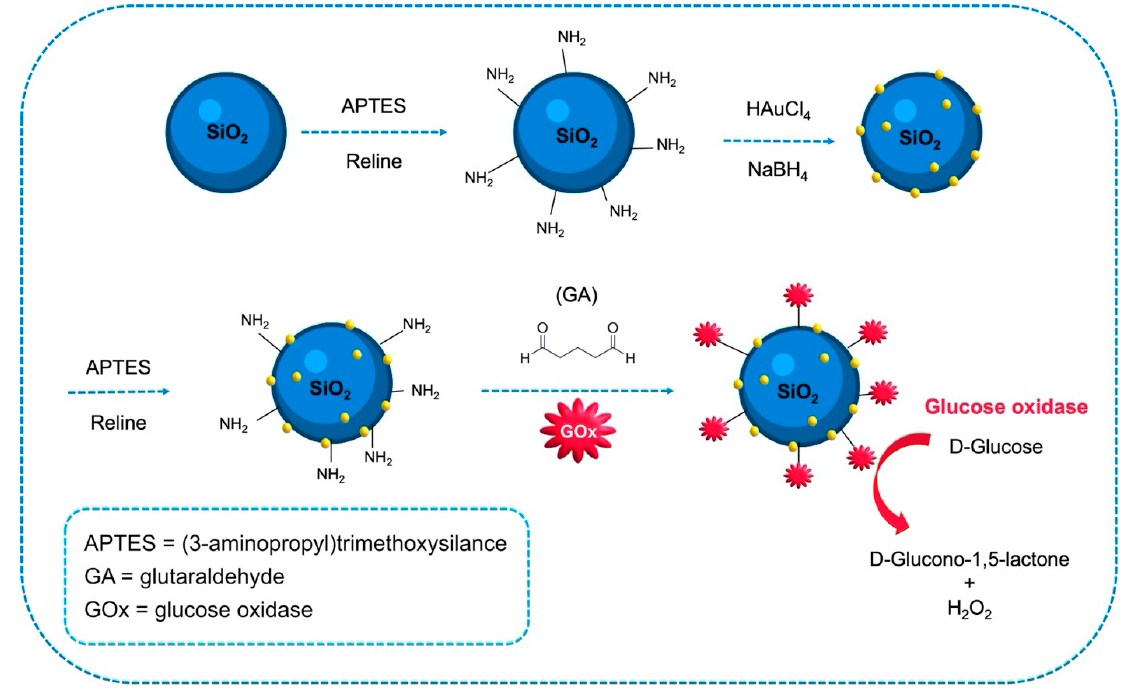
Figure 8. Scheme of the amine functionalization of SiO 2 NPs (green) in DES, and the following immobilization of AuNPs (yellow) and of glucose oxide (GOx) on the nanoparticle surface. (Adapted from [67] with permission.)